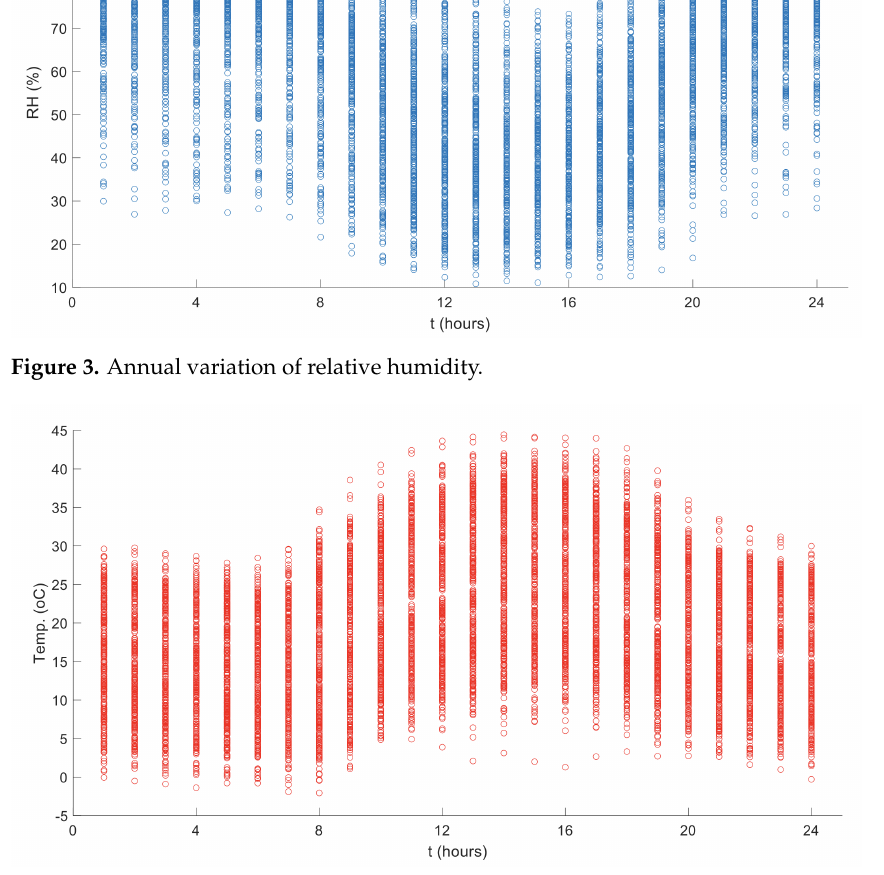
Figure 4. Annual variation in temperature.